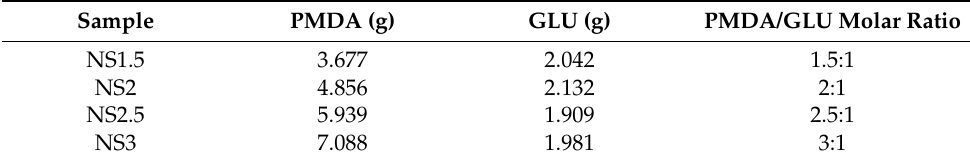
Table 1. Amounts of PMDA and of GLU and molar ratios used for the nanosponge synthesis. Sample PMDA